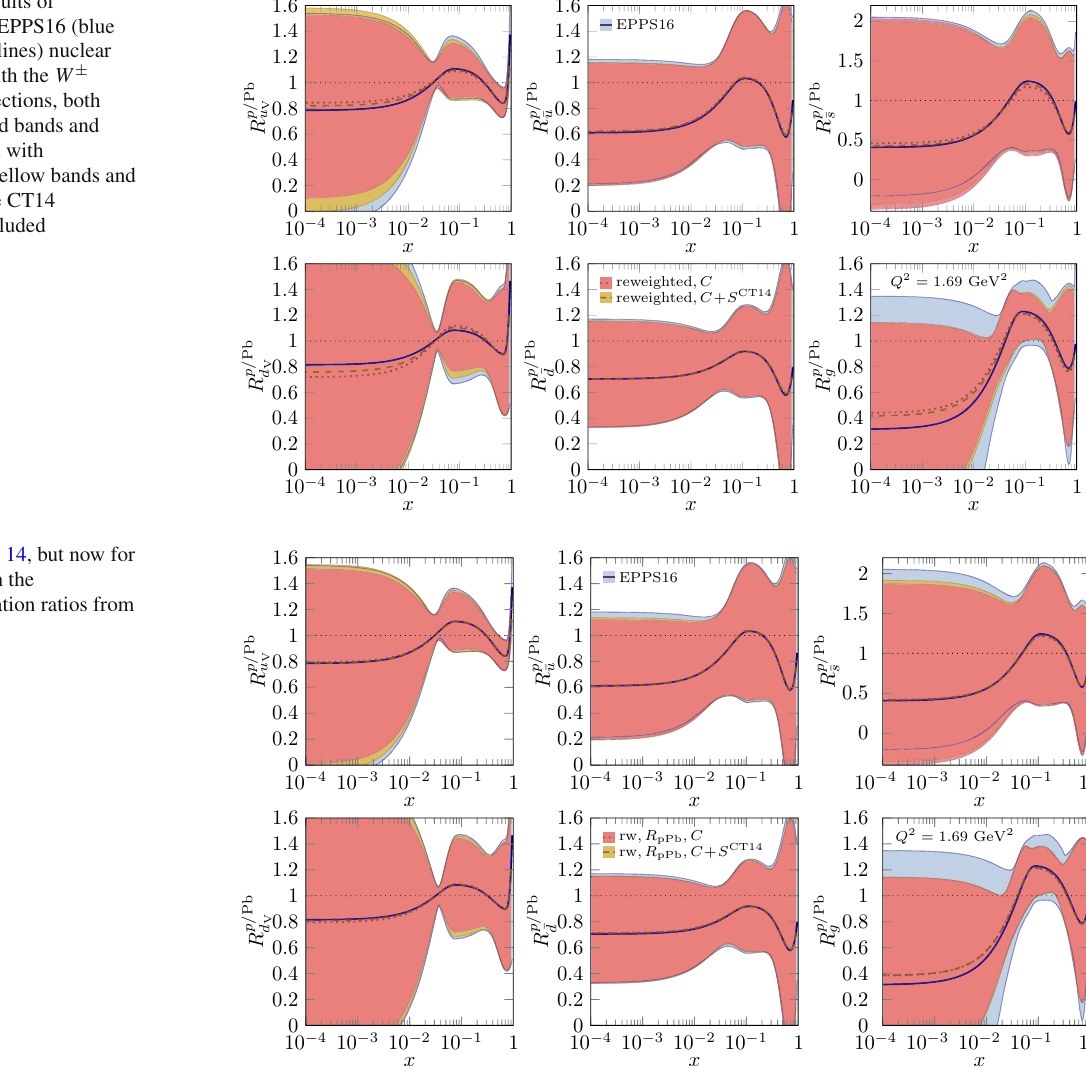
Fig. 14 The results of reweighting the EPPS16 (blue bands and solid lines) nuclear modifications with the W ± absolute cross sections, both without (“ C ”, red bands and dotted lines) and with (“ C + S CT14 ”, yellow bands and dashed lines) the CT14 uncertainties included